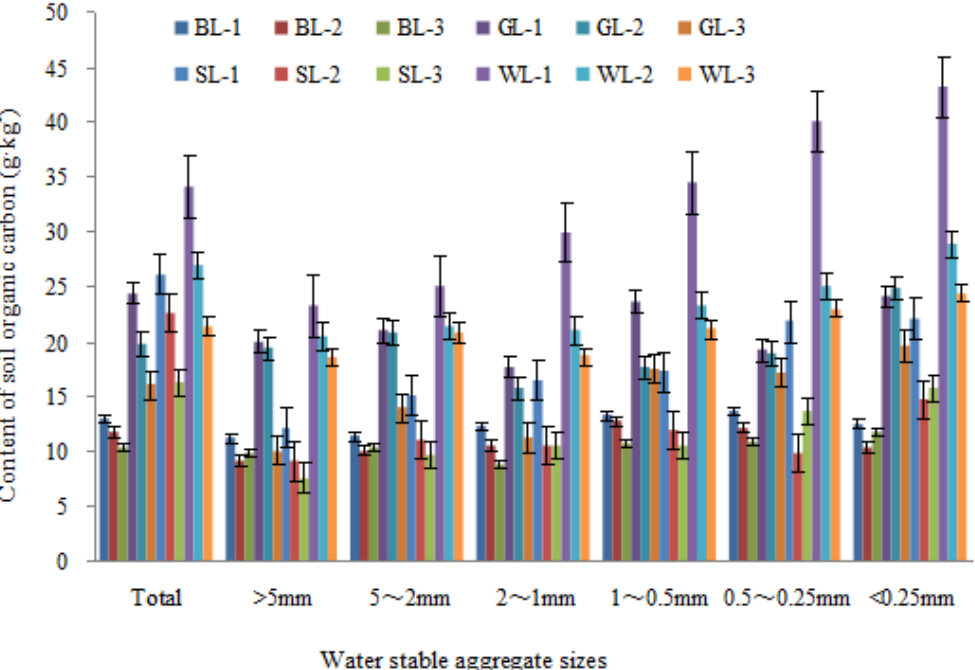
Figure 1. SOC in different water-stable aggregate sizes under different vegetation types (mean ± SE, n = 3. BL1, BL2, BL3, GL1, GL2, GL3, SL1, SL2, SL3, WL1, WL2, and WL3 represent 0–20 (1), 20–40 (2), and 40–60cm (3) soil layers of bare land (BL), grassland (GL), shrubland (SL), and woodland (WL), respectively). Table 2. Contribution rates of water-stable aggregates organic carbon to SOC under different vegetation types (%, mean ± SE, n = 3). WSA sizes (%) Vegetation